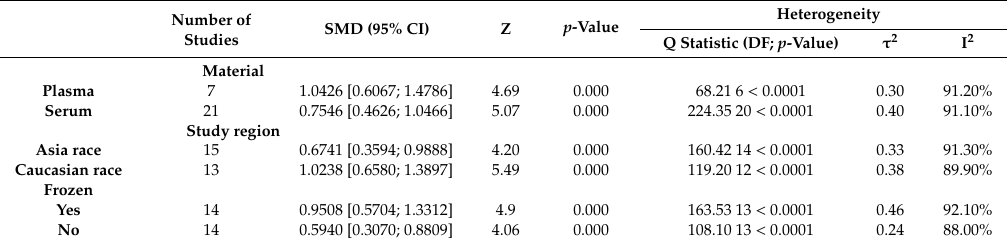
Table 3. Subgroup analyses of fetuin-A between NAFLD participants and